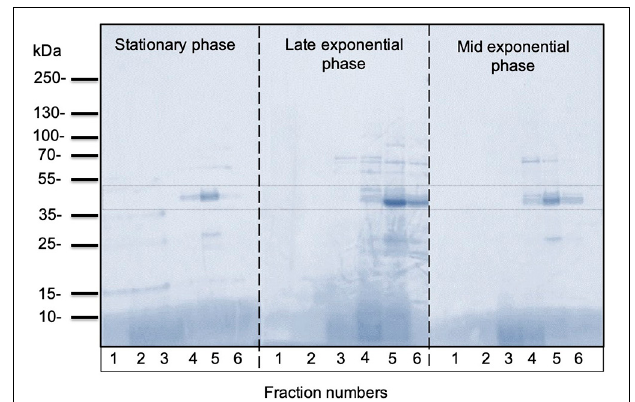
FIGURE 5 | Representative SDS-PAGE analysis of OMVs isolated from C. ochracea. Protein profiles of OMVs isolated from cultures of different growth phases; stationary phase (pH: 5.1), late exponential phase (pH: 5.3), and mid-exponential phase (pH: 5.7). The gel was stained with Coomassie Brilliant